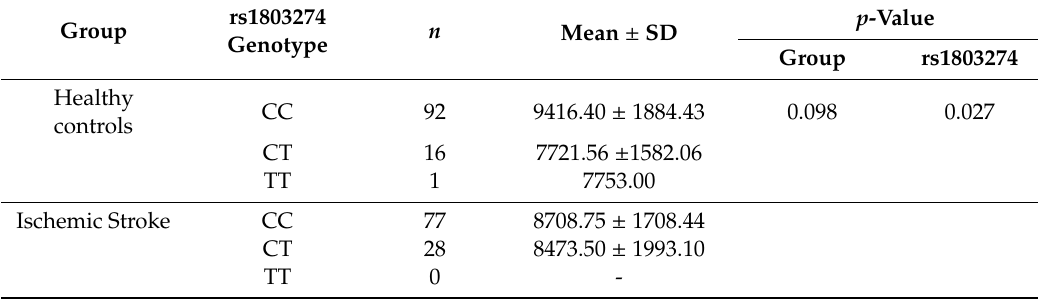
Table 4. The association of plasma BChE activity (mU / mL) between the groups and